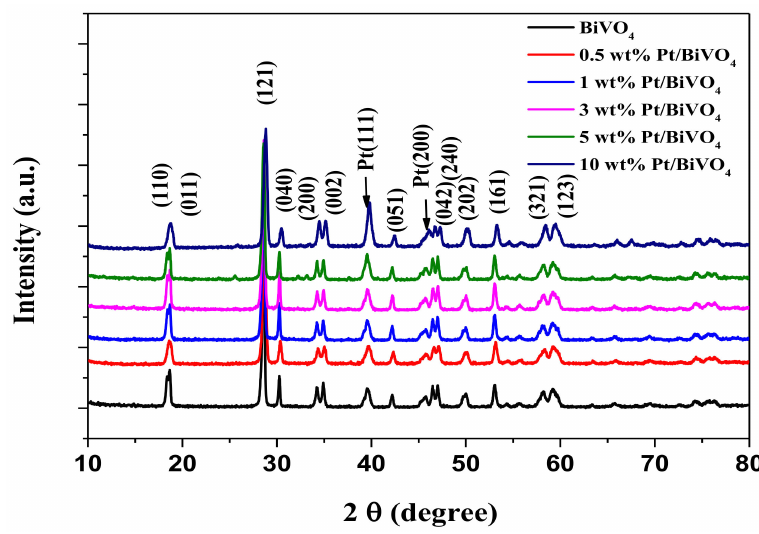
Figure 2. XRD patterns of different contents for Pt/BiVO 4